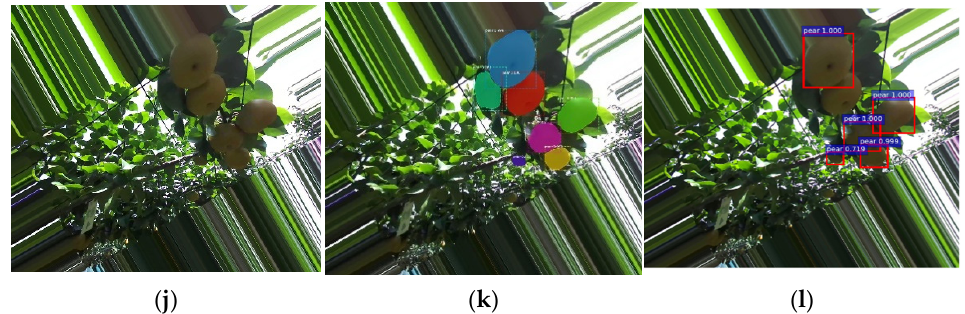
Figure 14. Results of Mask-R CNN in rotation angles. Recognition of ( a – c ): separated pear in low light; ( d – f ): aggregated pears in low light; ( g – i ): separated pears in strong light, and ( j – l ) aggregated pears in strong light ( a , d , g , j ) Original image; ( b , e , h , k ) Testing image in Mask R-CNN; and ( c , f , i , l ) Testing image in Faster R-CNN.